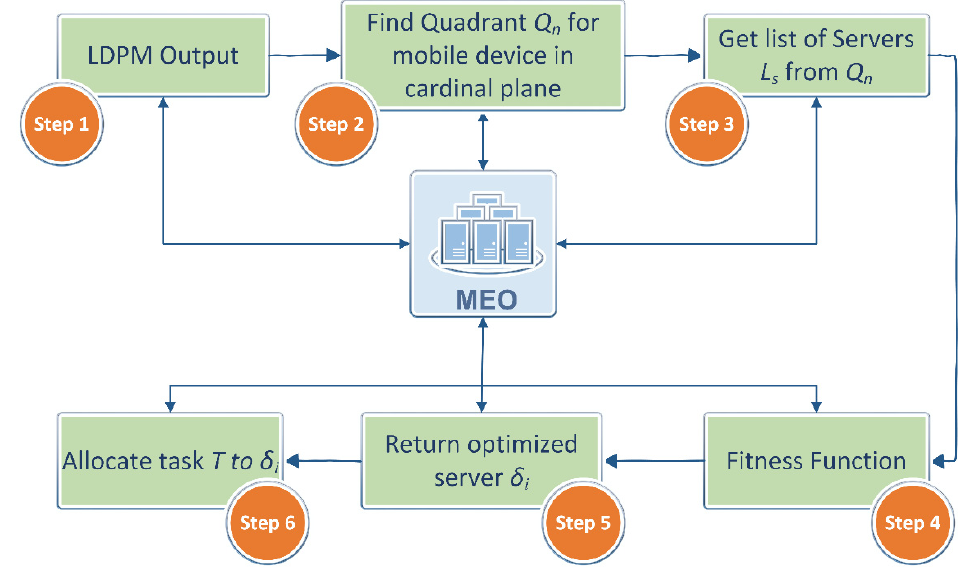
Figure A2. Overview of TPM.